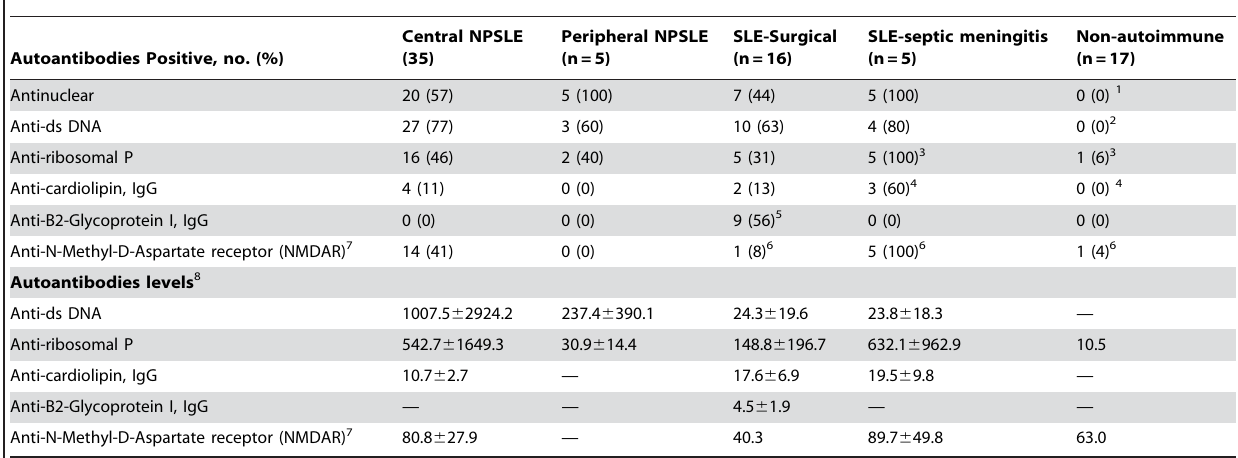
Table 4. Prevalence and levels of autoantibodies in cerebrospinal fluid from patients with NPSLE and controls.